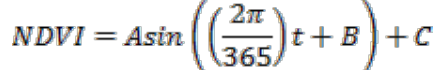
Figure 6. NDVI time-series in 3D Through least squares fitting of the time series data, a model for the seasonal trend can be obtained as: